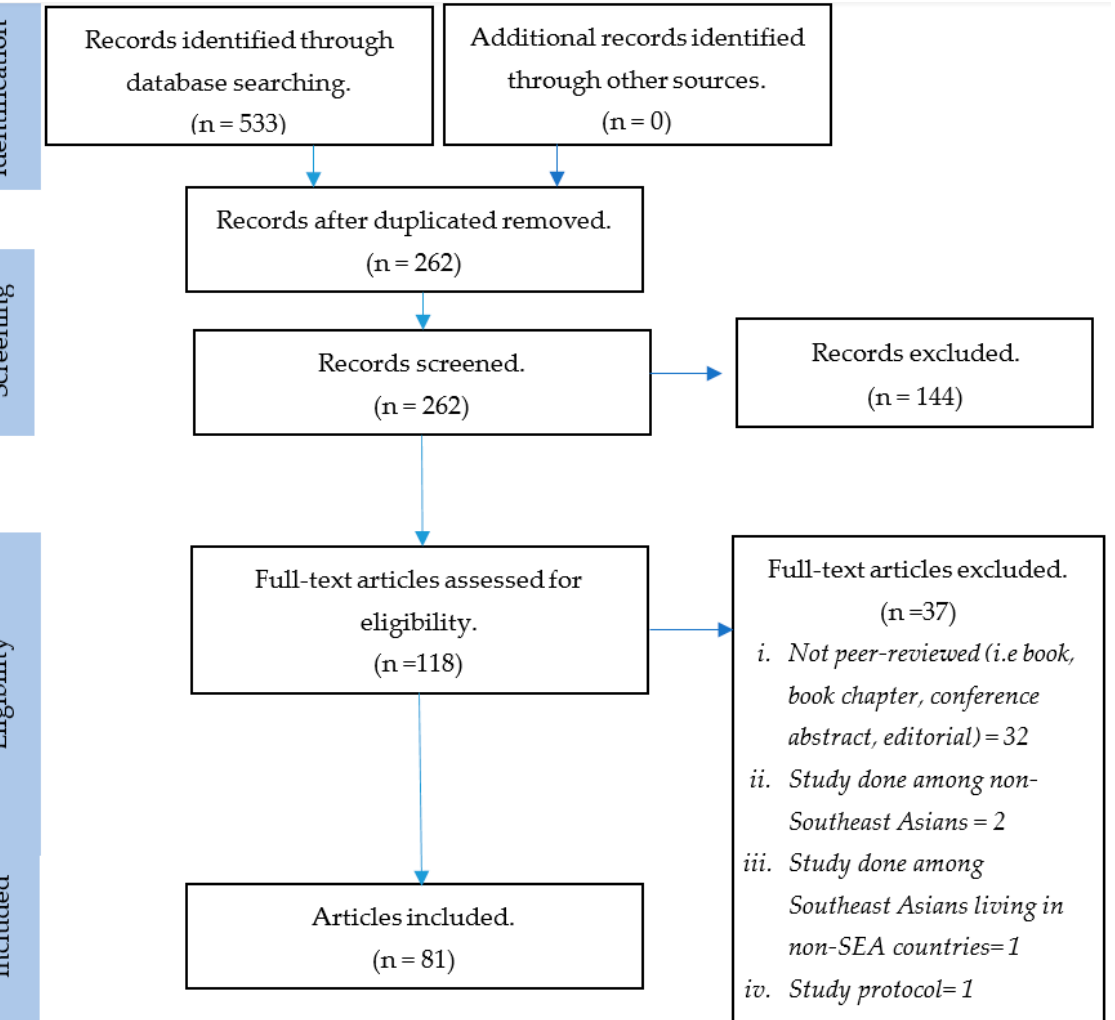
Figure 1. PRISMA flow chart of the article selection process.